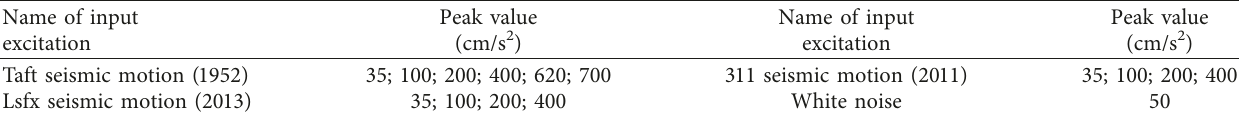
Table 4: Details of the test schemes structure B1 and